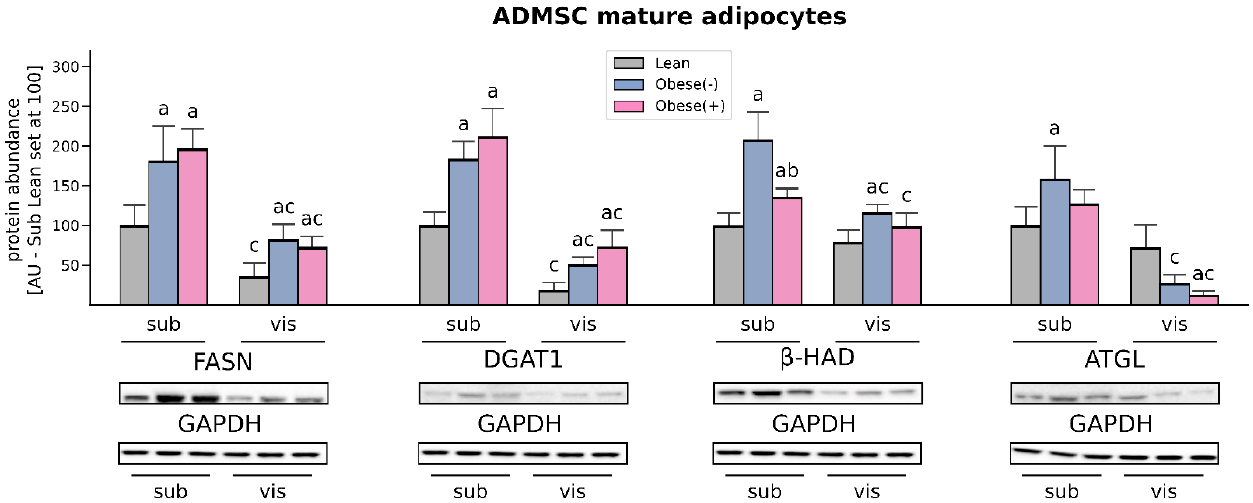
Figure 7. Protein content of enzymes involved in fatty acid synthesis and utilization (FASN, DGAT1, β -HAD, ATGL) in adipocytes differentiated from subADMSCs and visADMSCs of lean and mor- bidly obese women. Values are expressed in arbitrary units; the mean in adipocytes differentiated from the subADMSCs’ lean control was set at 100. Representative Western Blot images are shown. a–difference vs. Lean group in the studied tissue; b–difference vs. Obese(-) group in the studied tissue; c–difference between adipocytes differentiated from visADMSCs vs. subADMSCs within the patient metabolic status. Data are presented as mean ± SD ( n = 3 for each study group, measurements taken in duplicate). p < 0.05. Designation of the groups: Obese(-)–obese without metabolic syndrome patients; Obese(+)–obese with metabolic syndrome